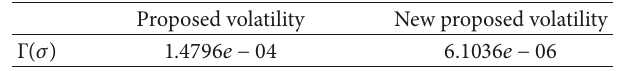
Table 4: The value of Γ(𝜎) .